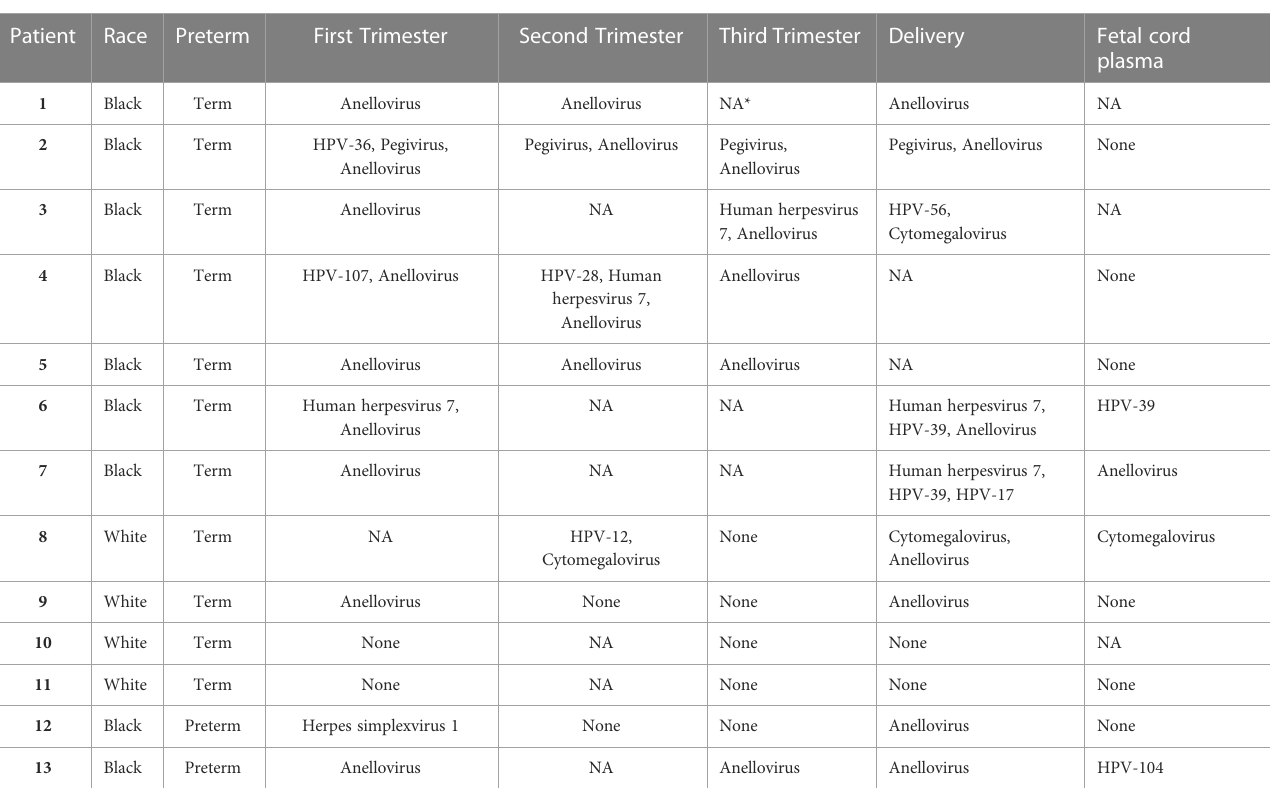
TABLE 2 Viruses detected longitudinally by